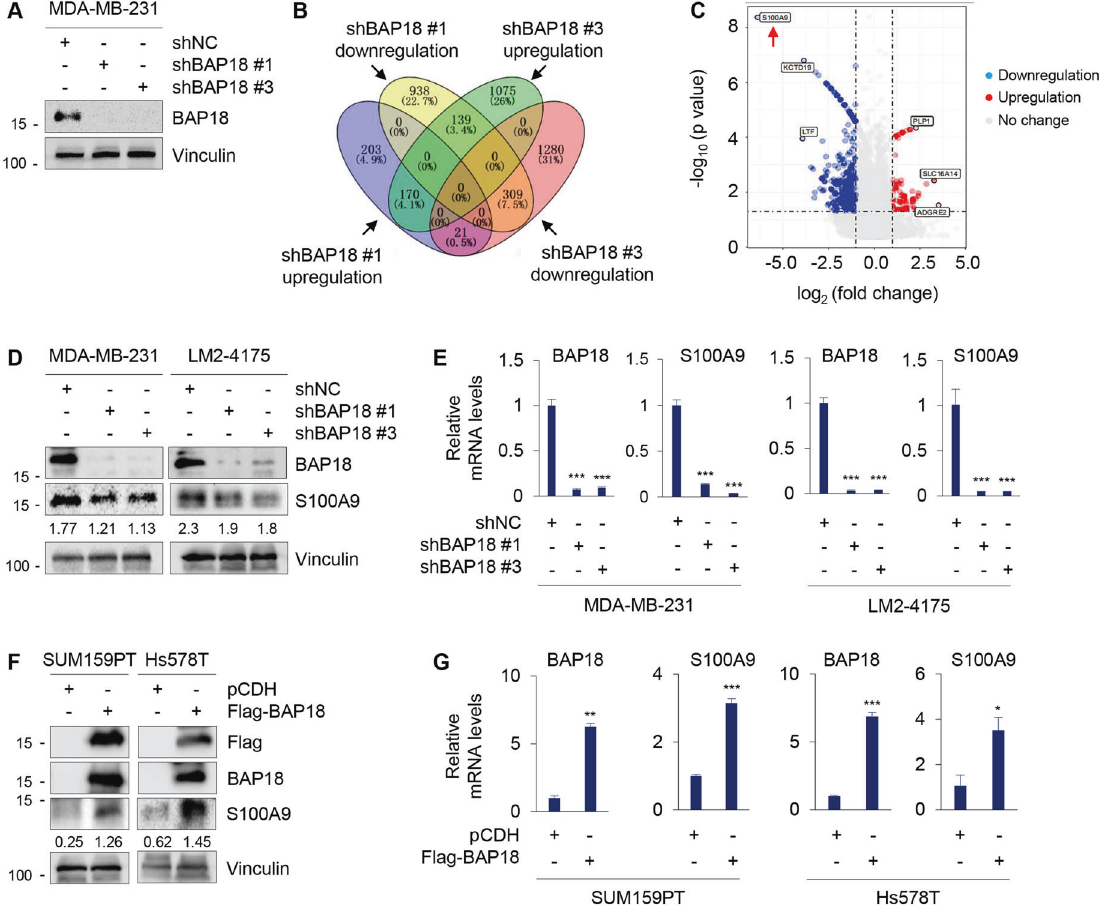
Fig. 5 S100A9 is a downstream target gene of BAP18. A shRNA-mediated knockdown of BAP18 in MDA-MB-231 cells was veri fi ed by immunoblotting with the indicated antibodies. B Differentially expressed genes between shBAP18 (#1 and #3) and shNC group according to fold change ≥ 2 or ≤ − 2. C Volcanic map of differentially expressed genes. D , E The protein ( D ) and mRNA ( E ) levels of S100A9 in MDA-MB-231 and LM2-4175 cells stably expressing shNC and shBAP18. F , G The protein ( F ) and mRNA ( G ) levels of S100A9 in SUM159PT and Hs578T cells stably expressing pCDH and Flag-BAP18. * p < 0.05; ** p < 0.01; *** p <